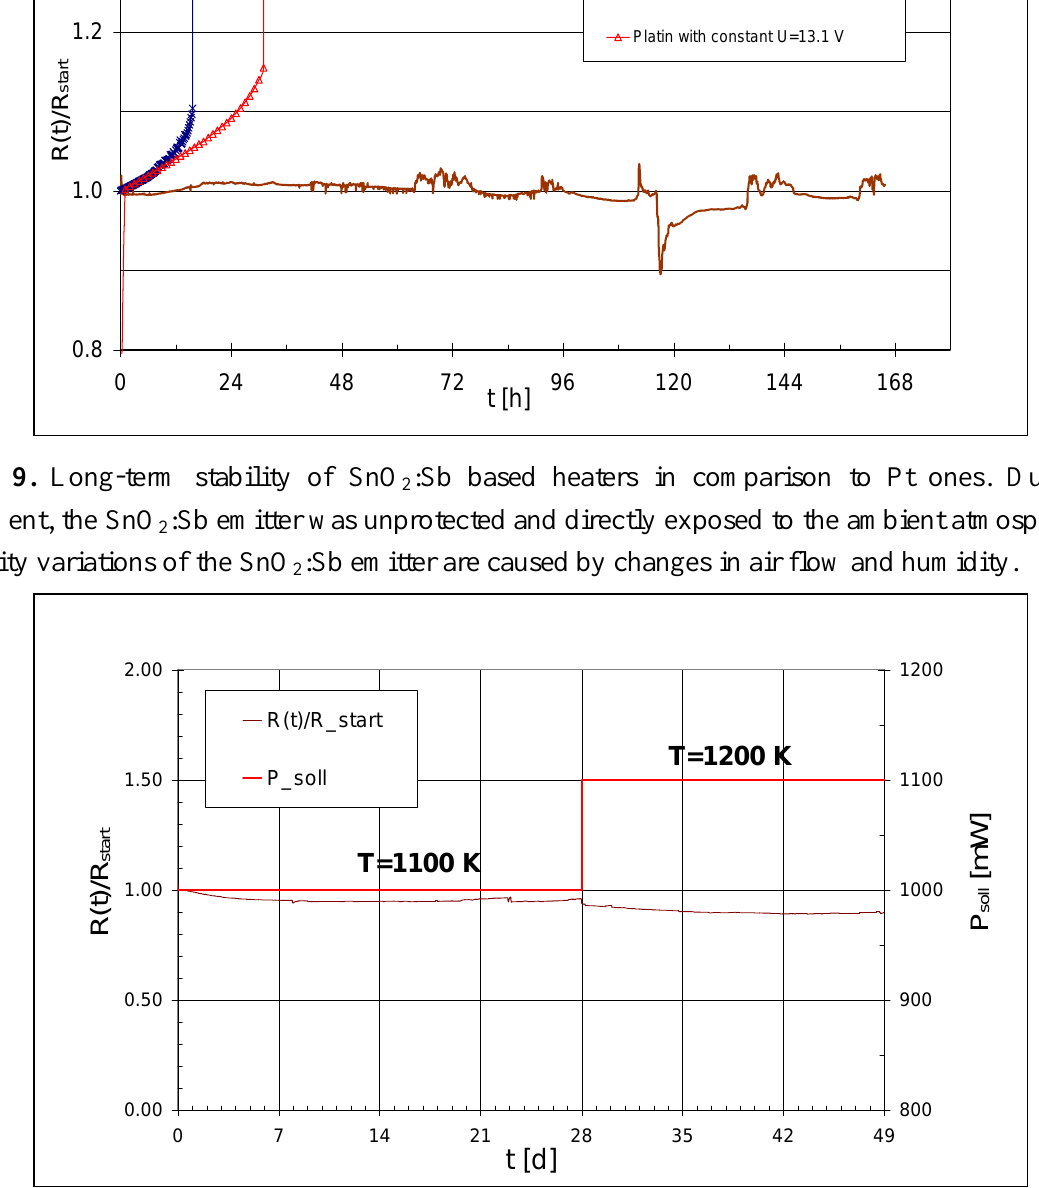
Figure 10. Long-term durability test of heater metallisation based on doped tin